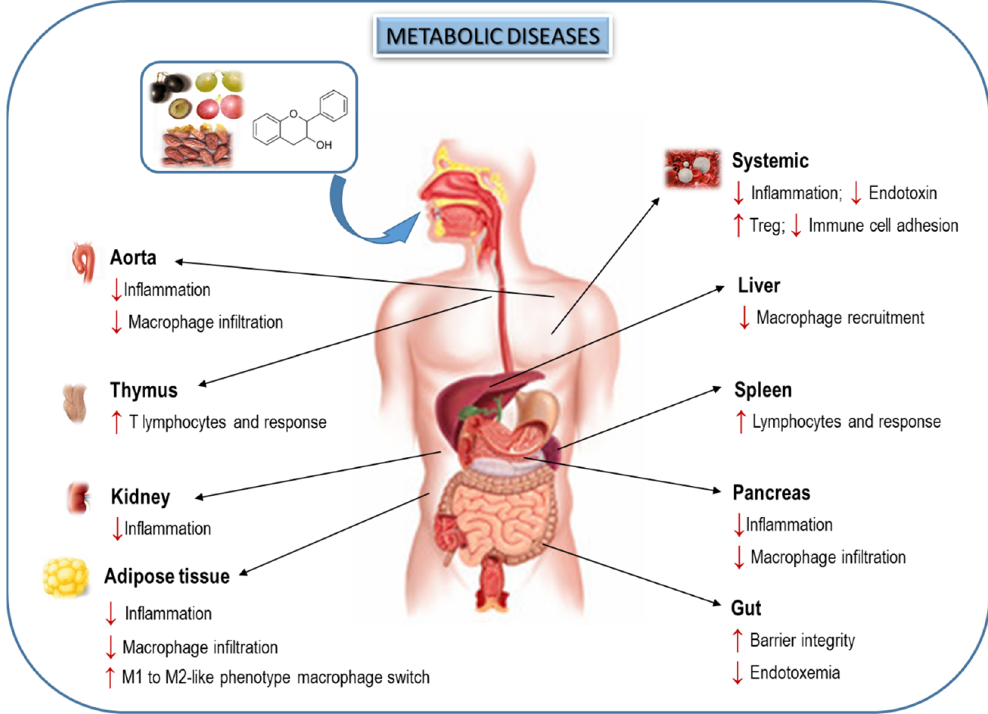
Figure 2. Flavanols and flavanol-rich foods exert beneficial effects related to inflammation and immune system on relevant metabolic diseases (diabetes, obesity and metabolic syndrome). The arrow indicates an increase ( ↑ ) or decrease ( ↓ ) in the level or activity of the different parameters analyzed.